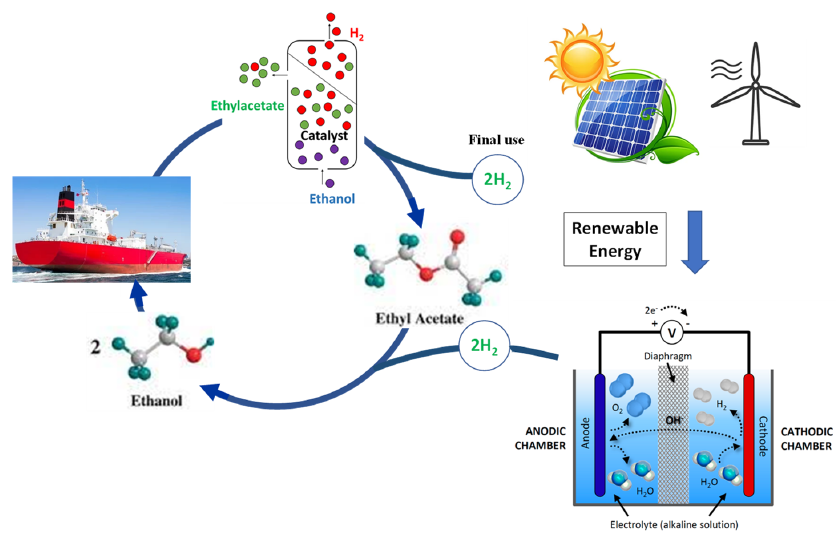
Figure 11. Overview of coupling ethanol dehydrogenation and ethyl acetate hydrogenation of ethyl acetate to ethanol with the scope of storing hydrogen inside the ethanol molecule and transporting it to a place of final use.